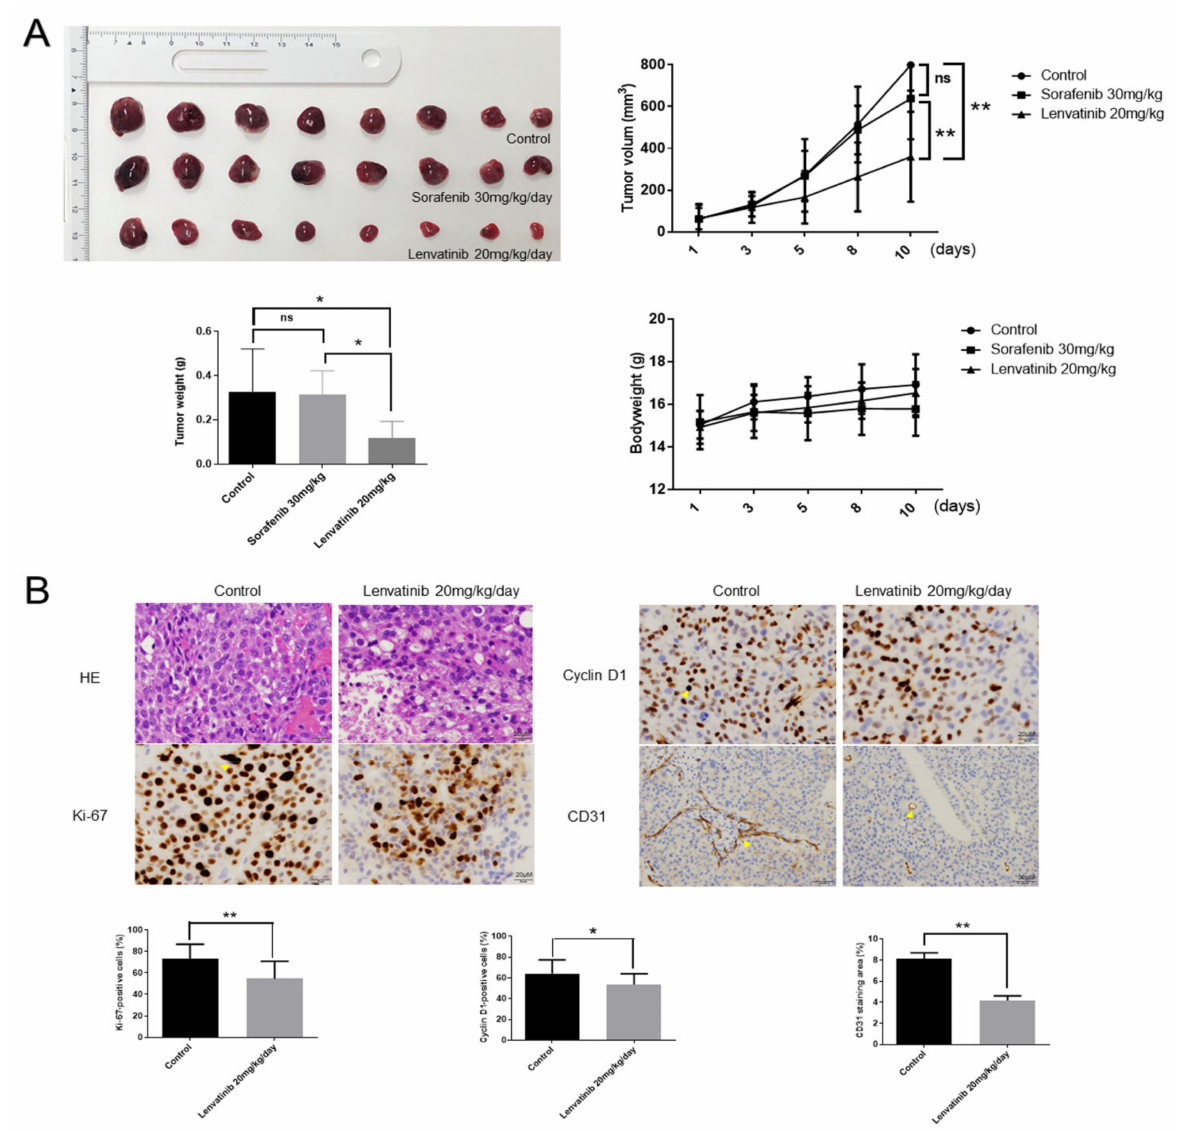
Figure 8. Lenvatinib inhibits Huh-7 sorafenib-resistant cell proliferation in vivo. ( A ) Lenvatinib 20 mg/kg/day (5 days/week) significantly inhibits tumor growth compared with control and sorafenib 30 mg/kg/day (5 days/week) (n = 8 per group). ( B ) Hematoxylin and eosin (H&E) staining and immunohistochemical staining of ki-67, cyclin D1 and CD31 proteins in the subcutaneous xenograft model. Ki-67-positive cells and cyclin D1-positive cells in the lenvatinib-treated groups were reduced in numbers compared with that in the control group. CD31 staining area in the lenvatinib-treated groups was decreased compared with that in the control group. Data are presented as mean ± standard deviation (SD). * p < 0.05, ** p < 0.01, ns, no